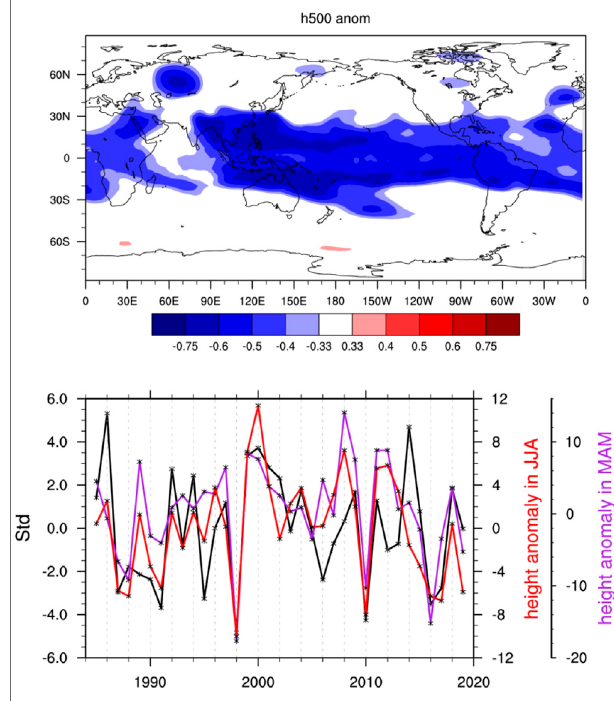
FIGURE10| Average prediction skillsoftheWNPSH (A) ridgepoint and (B) ridgelineindicesofdifferentleadtimes in Figure7 .Thered linesrepresent PS skills, the black lines do standard deviation, and the purple lines do standard deviation after detrending.